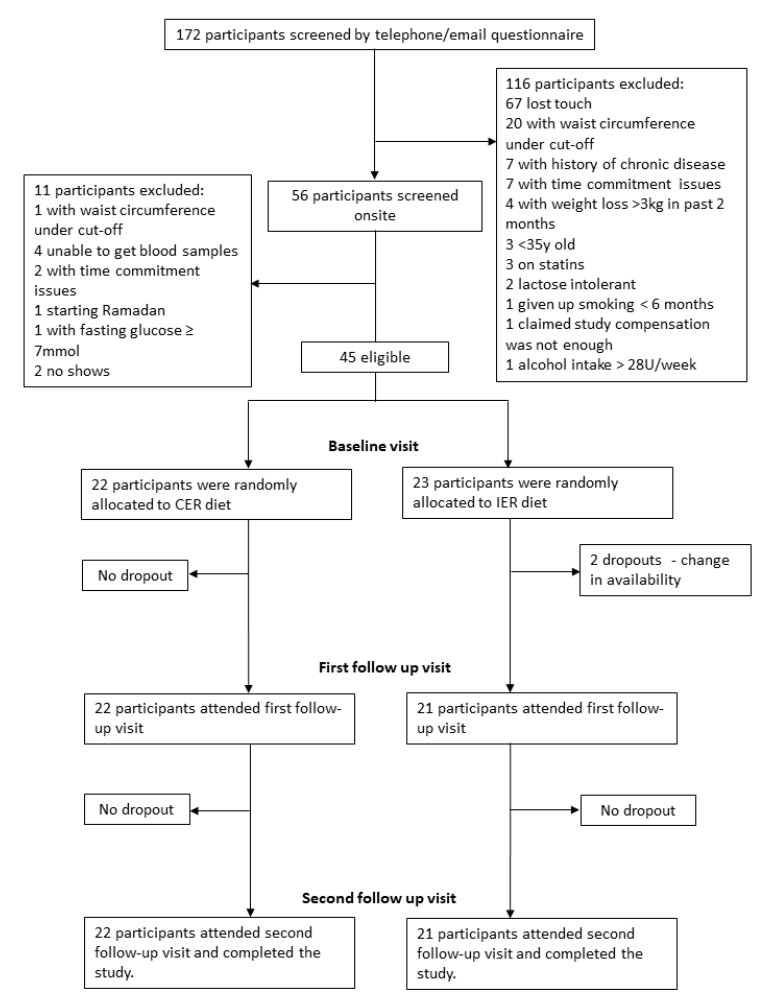
Figure 1. CONSORT (Consolidated Standards of Reporting Trials) diagram for the Met-IER study (Metabolic effects of Intermittent Energy Restriction). IER: intermittent energy restriction; CER: continuous energy restriction.